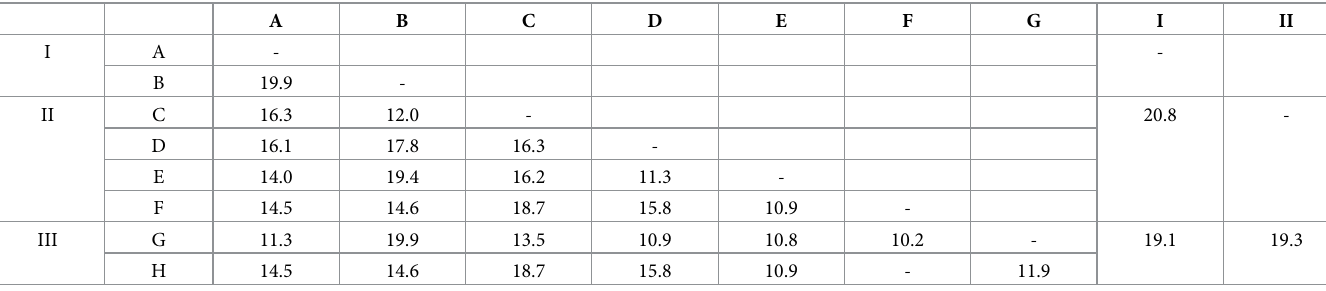
Table 3. Estimates of migration rate between groups and